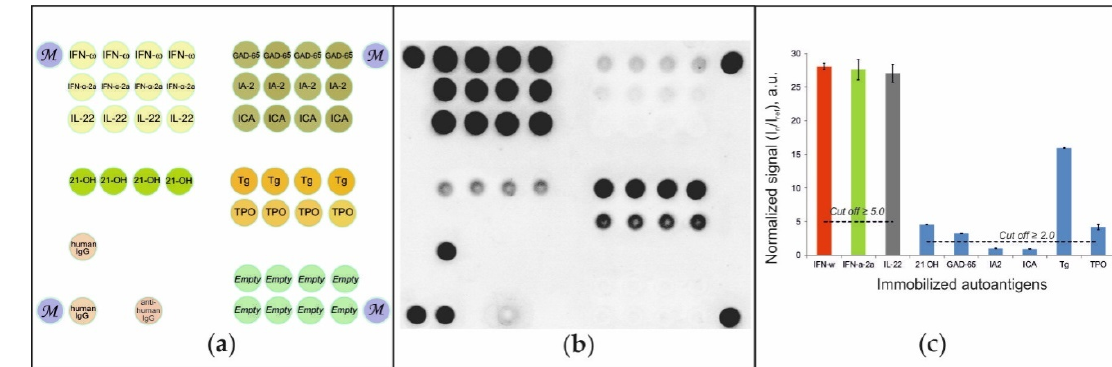
Figure 1. ( a ) Microarray configuration; ( b ) fluorescence image of the microarray; and ( c ) normalized signals from the microarray elements after assay of the serum sample from patient #49 with APS-1. Designations: IFN-ω—ntierferon omega; IFN-α-2a—interferon-alpha-2a; IL-22—interleukin 22; 21-OH—steroid 21 hydroxylase; GAD-65—glutamic acid decarboxylase 65 kDa; IA-2—tyrosine phosphatase-like autoantigen; ICA—islet cell autoantigen 1; TPO—thyroid perox- idase; TG—thyroglobulin; M—marker; human IgG—human immunoglobulin G; anti-human IgG—mouse anti-human immunoglobulin G; Empty—reference gel elements without immobilized protein.